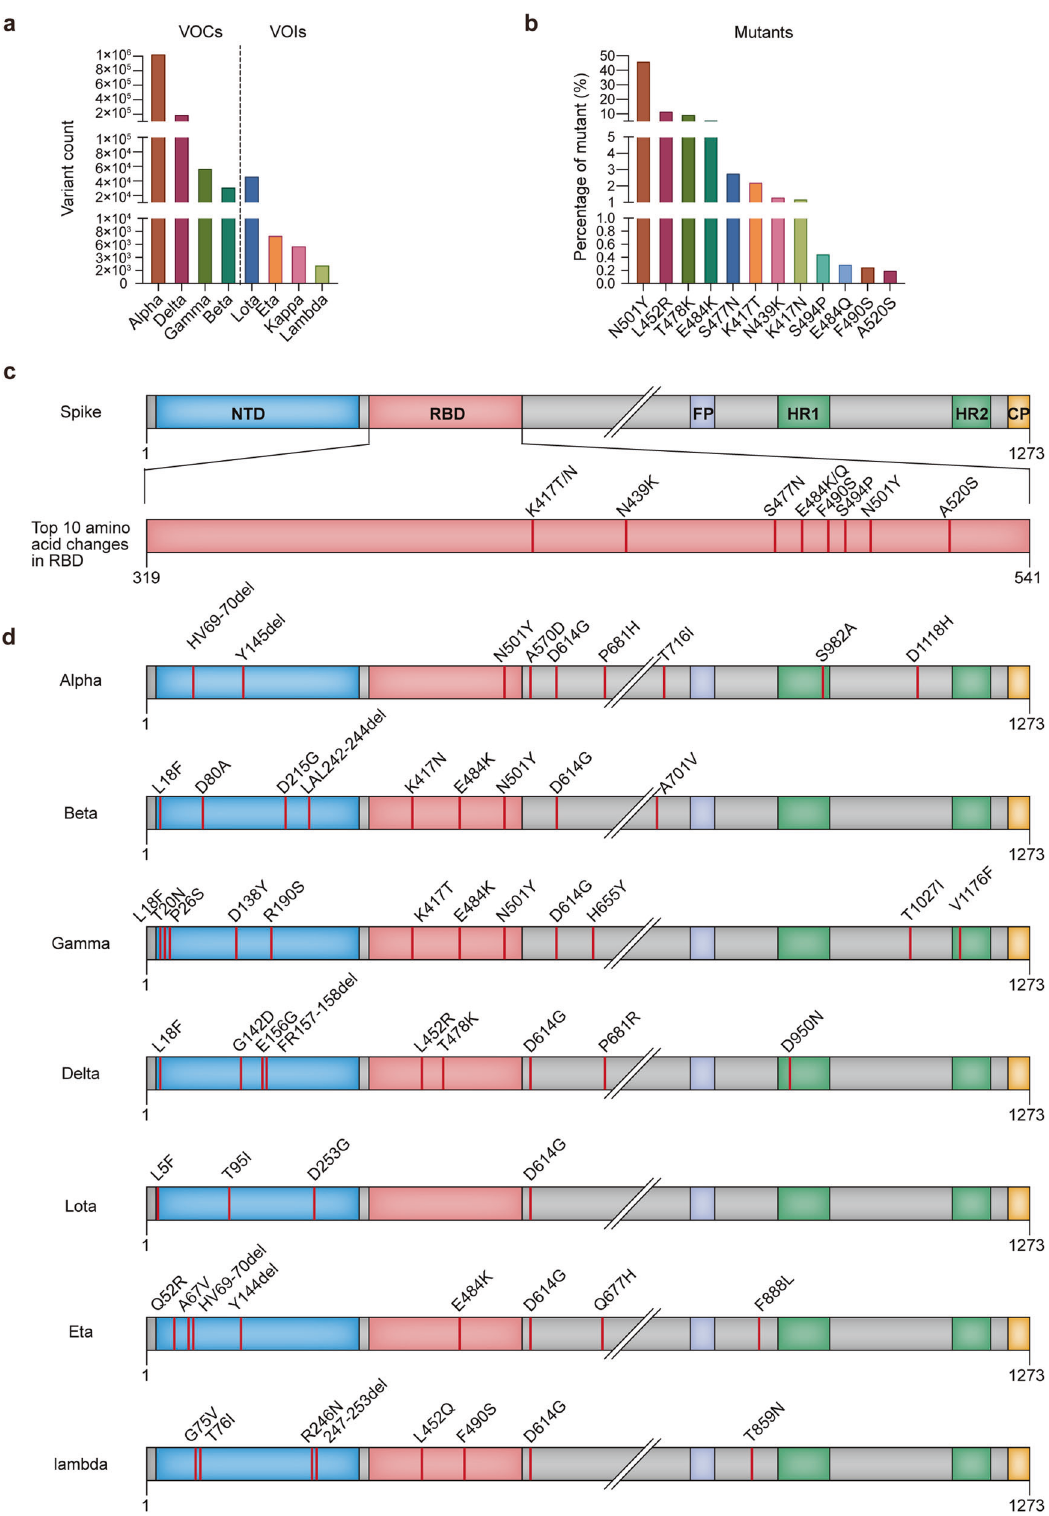
Fig. 1 Circulating variants and most common amino acid changes in SARS-CoV-2 S protein. a VOC and VOI count. The VOC and VOI count data were obtained from outbreak.org (https://outbreak.info/situation-reports?name) up to July 19th, 2021. VOCs and VOIs were classi fi ed by the WHO. b The percentage of the top 12 amino acid changes in S protein. These data were sourced from COVIDCG.org (https://covidcg. org/?tab = home&unde fi ned = All&selectedGene = S&residueCoordinates = 319,541&startDate = 2019-12-15&unde fi ned = All) up to July 19th, 2021. c The amino acid changes introduced in this study. The most common amino acid changes except for L452R and T478K are indicated. (d) The illustration of the VOCs and VOIs. Delta was used as the template on which to add mutations. L452R and T478K located in the RBD of B.1.617.2 were not included in the additional mutagenesis. S spike, SARS-CoV-2 severe acute respiratory syndrome coronavirus 2, VOC variant of concern, VOI variant of interest, WHO World Health Organization, COVID coronavirus